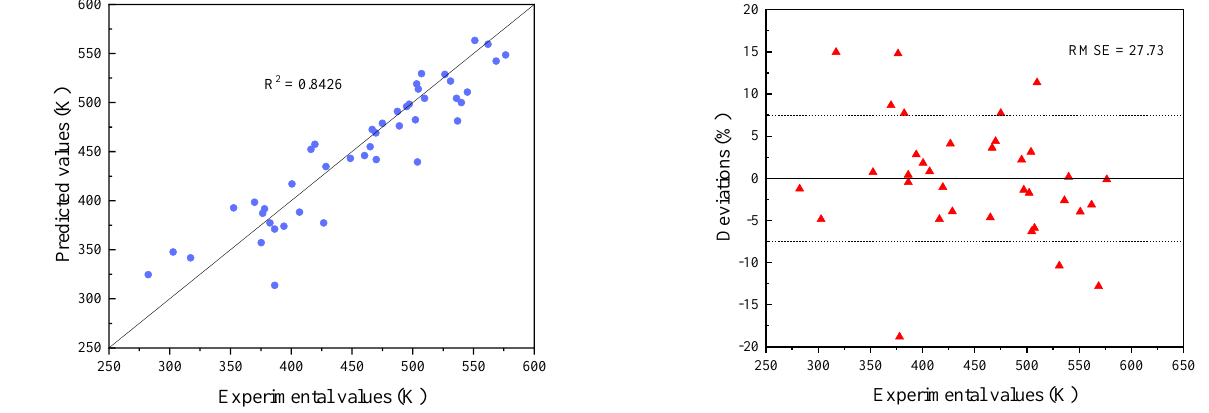
Figure 4. Predictive performance of the SVR + modified Pubchem